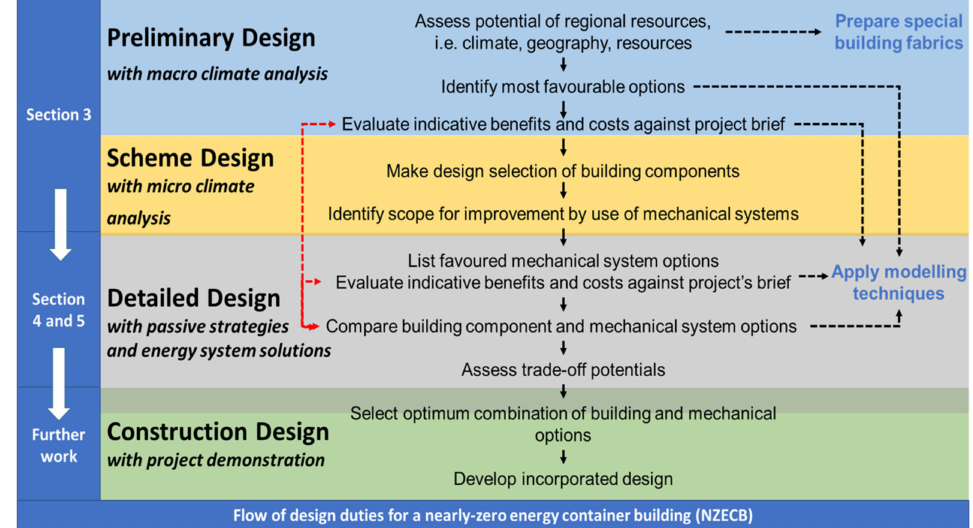
Figure 1. Design stages for a nearly zero-energy container